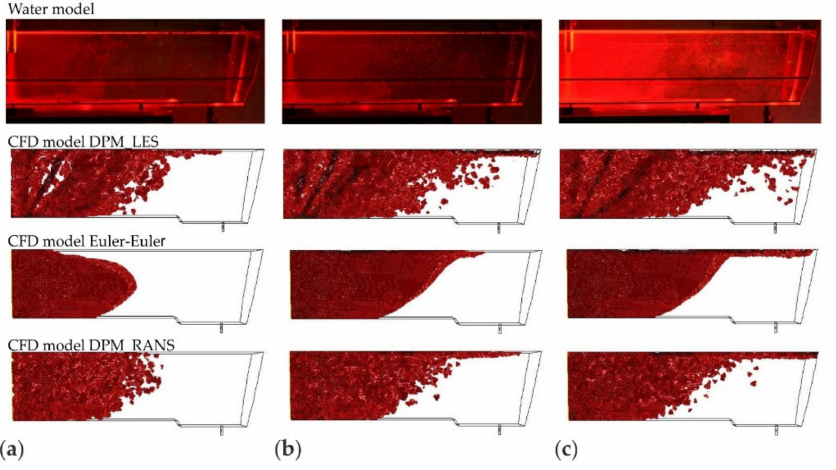
Figure 10. The location of the microparticles (fraction 100 µ m) in the tundish model for a duration of, respectively: ( a ) 25, ( b ) 60, ( c ) 120